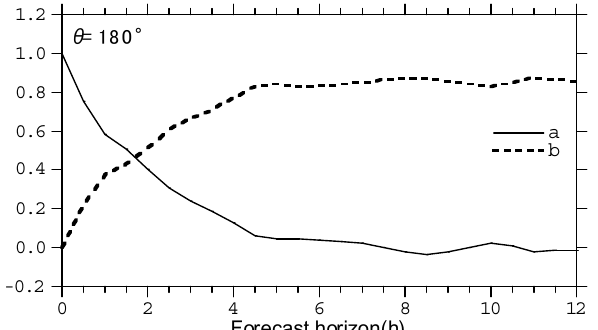
Figure 4. The function 𝑓 (cid:4672)(cid:4698)𝐮(cid:3365) (cid:3047)(cid:2878)(cid:3038)|(cid:3047)(cid:2924)(cid:2933)(cid:2926) (cid:4698) , 𝜃 (cid:3047)(cid:2878)(cid:3038)|(cid:3047)(cid:2924)(cid:2933)(cid:2926) (cid:4673) in the mean wind speed forecast mode: (a) 𝜃 (cid:3047)(cid:2878)(cid:3038)|(cid:3047)(cid:2924)(cid:2933)(cid:2926) = 0° ; (b) 𝜃 (cid:3047)(cid:2878)(cid:3038)|(cid:3047)(cid:2924)(cid:2933)(cid:2926) = 180° . In the mean wind speed forecast model, the functions 𝑎(cid:4672)𝑘, 𝜃 (cid:3047)(cid:2878)(cid:3038)|(cid:3047)(cid:2924)(cid:2933)(cid:2926) (cid:4673) and 𝑏(cid:4672)𝑘, 𝜃 (cid:3047)(cid:2878)(cid:3038)|(cid:3047)(cid:2924)(cid:2933)(cid:2926) (cid:4673), which are used to take into account the on-site measurement, are also trained.